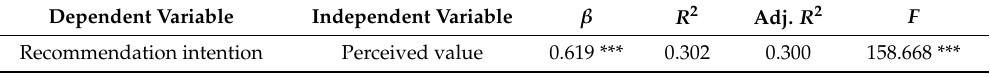
Table 6. Regression analysis between perceived value and recommendation intention.